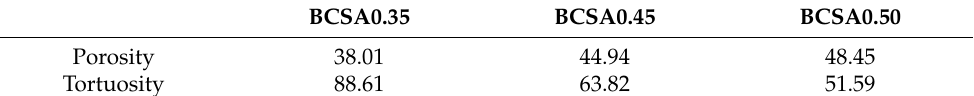
Figure 7. The electrical resistivity of BCSA cement pastes with various w / c ratio. Table 2. Porosity and tortuosity of BCSA cement pastes.